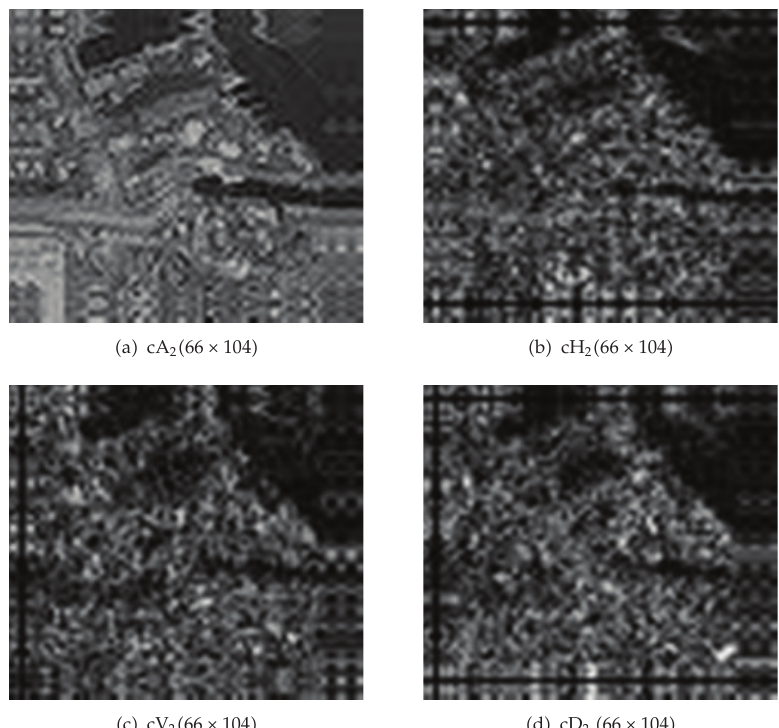
Figure 5: Second level decomposition of Image (cid:3) cA 1 (cid:4) : (cid:3) a (cid:4) approximation coe ffi cients, (cid:3) b (cid:4) horizontal cients, (cid:3) c (cid:4) vertical coe ffi cients, (cid:3) d (cid:4) diagonal coe ffi